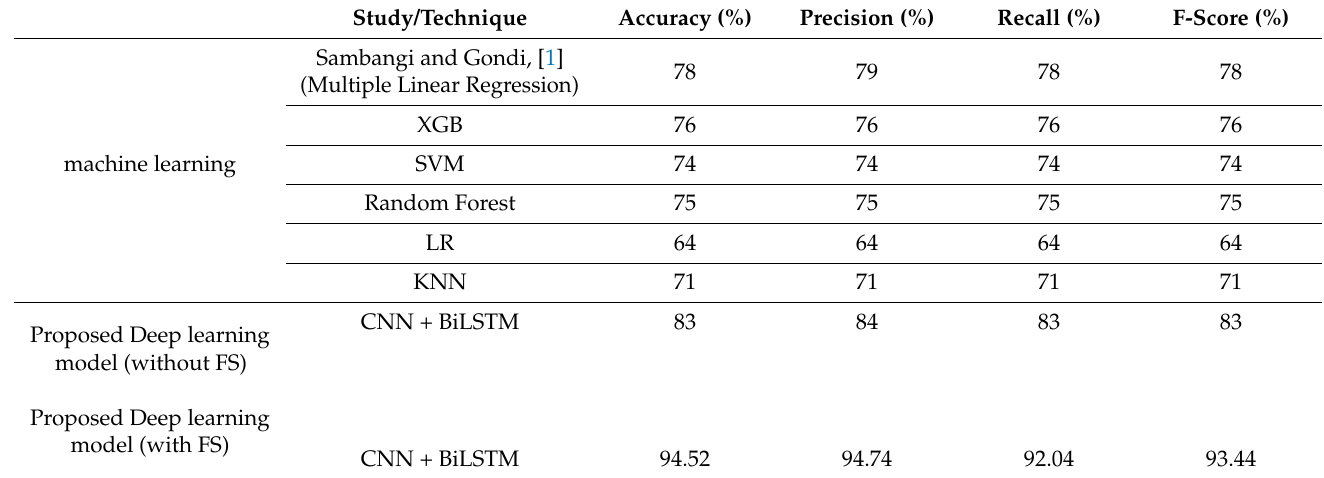
Table 8. Comparison of the proposed model to ML